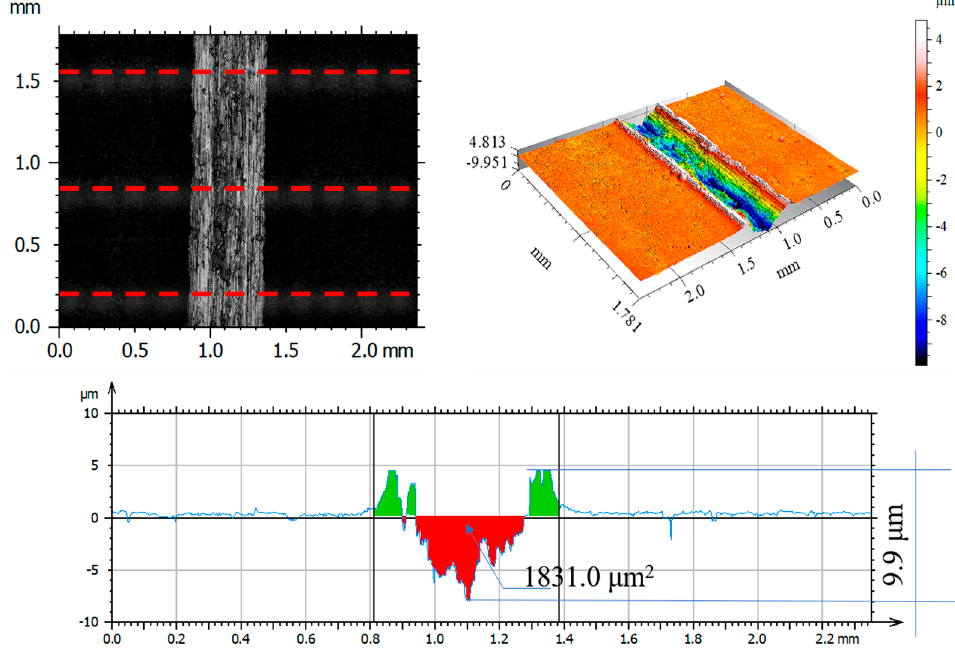
Figure 16. Optical and axonometric views of sample wear track and the wear profile on transverse cross-section after the RS-lubricated sliding of the oxygen ion-implanted steel 316L—Al 2 O 3 friction pair.